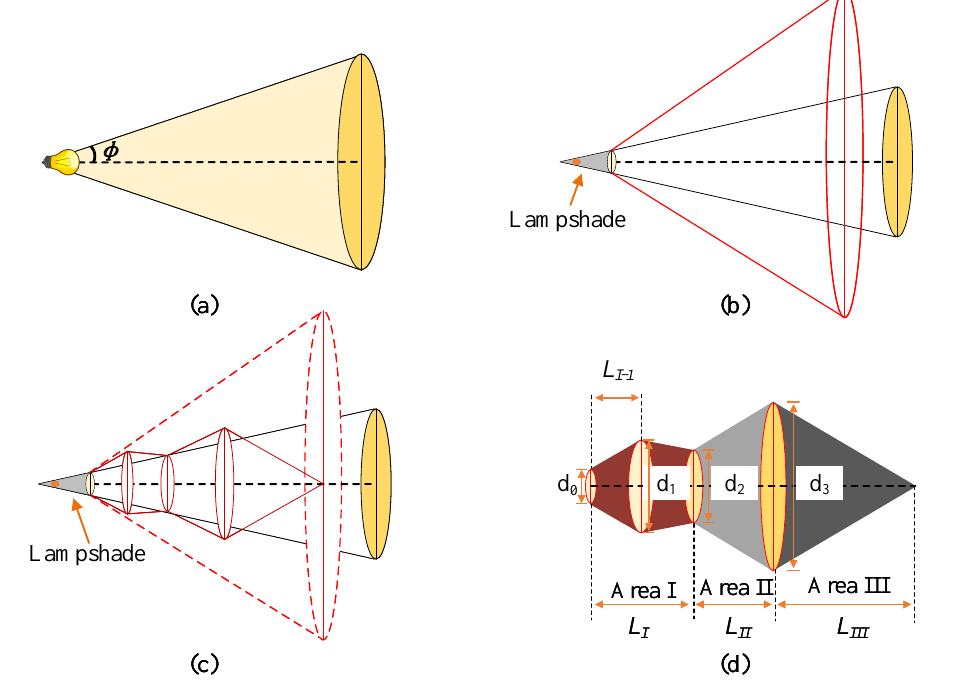
Figure 11. Experimental model. ( a ) Model of light radiation without lampshade. ( b ) Light reflection model with lampshade. ( c ) Receivable region of the optical signal for the reflection model. ( d ) Optical signal error-free distribution